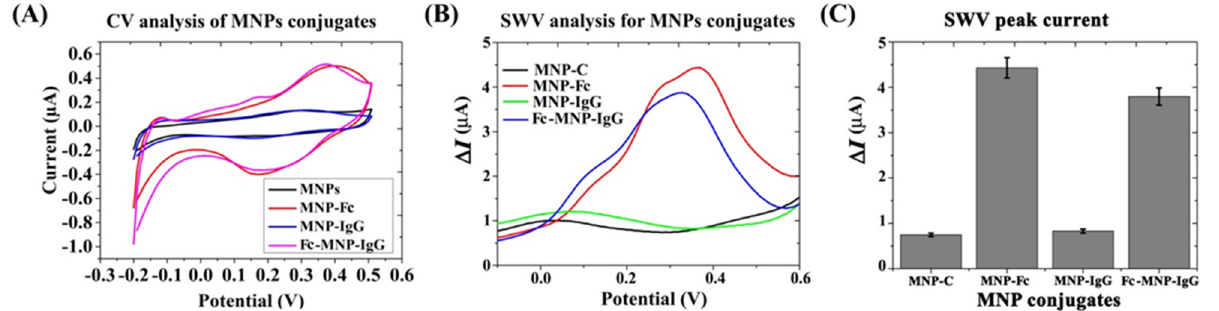
Figure 4. Electrochemical characterization of bi-functional MNPs (Fc-MNP-IgG) in PBS. ( A ) CV analysis of bare MNPs and conjugates. Redox peaks were found only in the Fc-MNP and Fc-MNP- IgG conjugates but not in the IgG-modified MNPs and MNPs control. ( B ) SWV analysis of MNPs conjugates. The square-wave voltammograms for MNPs control (black color), MNP-Fc conjugate (red color), MNP-IgG conjugate (green color), and bi-functional Fc-MNP-IgG conjugate (blue color). SWV parameters: amplitude 0.1 V; scan increment 0.01 V; frequency 20 Hz and duration 4 s. ( C ) The bar graph indicates peak current means for triplicate and error bars represent ±SD.